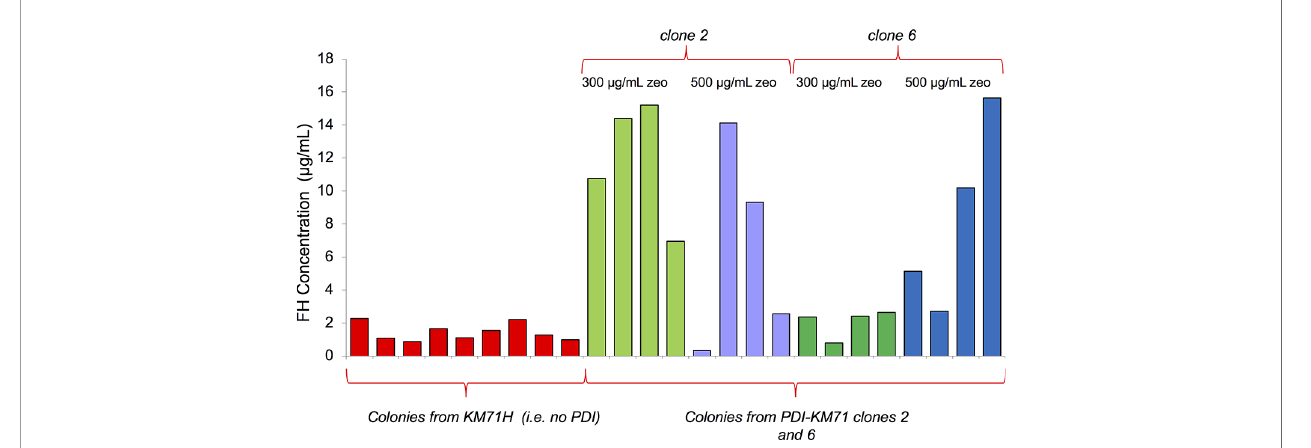
FIGURE 2 | Comparison of recombinant hFH production with and without co-production of PDI. KM71H, or two colonies of KM71- PDI , were transformed with pPicZ a containing a gene for human FH. After selection with 300 or 500 µg/mL zeocin, four single colonies in each case were used to inoculate 25-mL test growths. An ELISA (see Methods) was used to estimate recombinant hFH production in